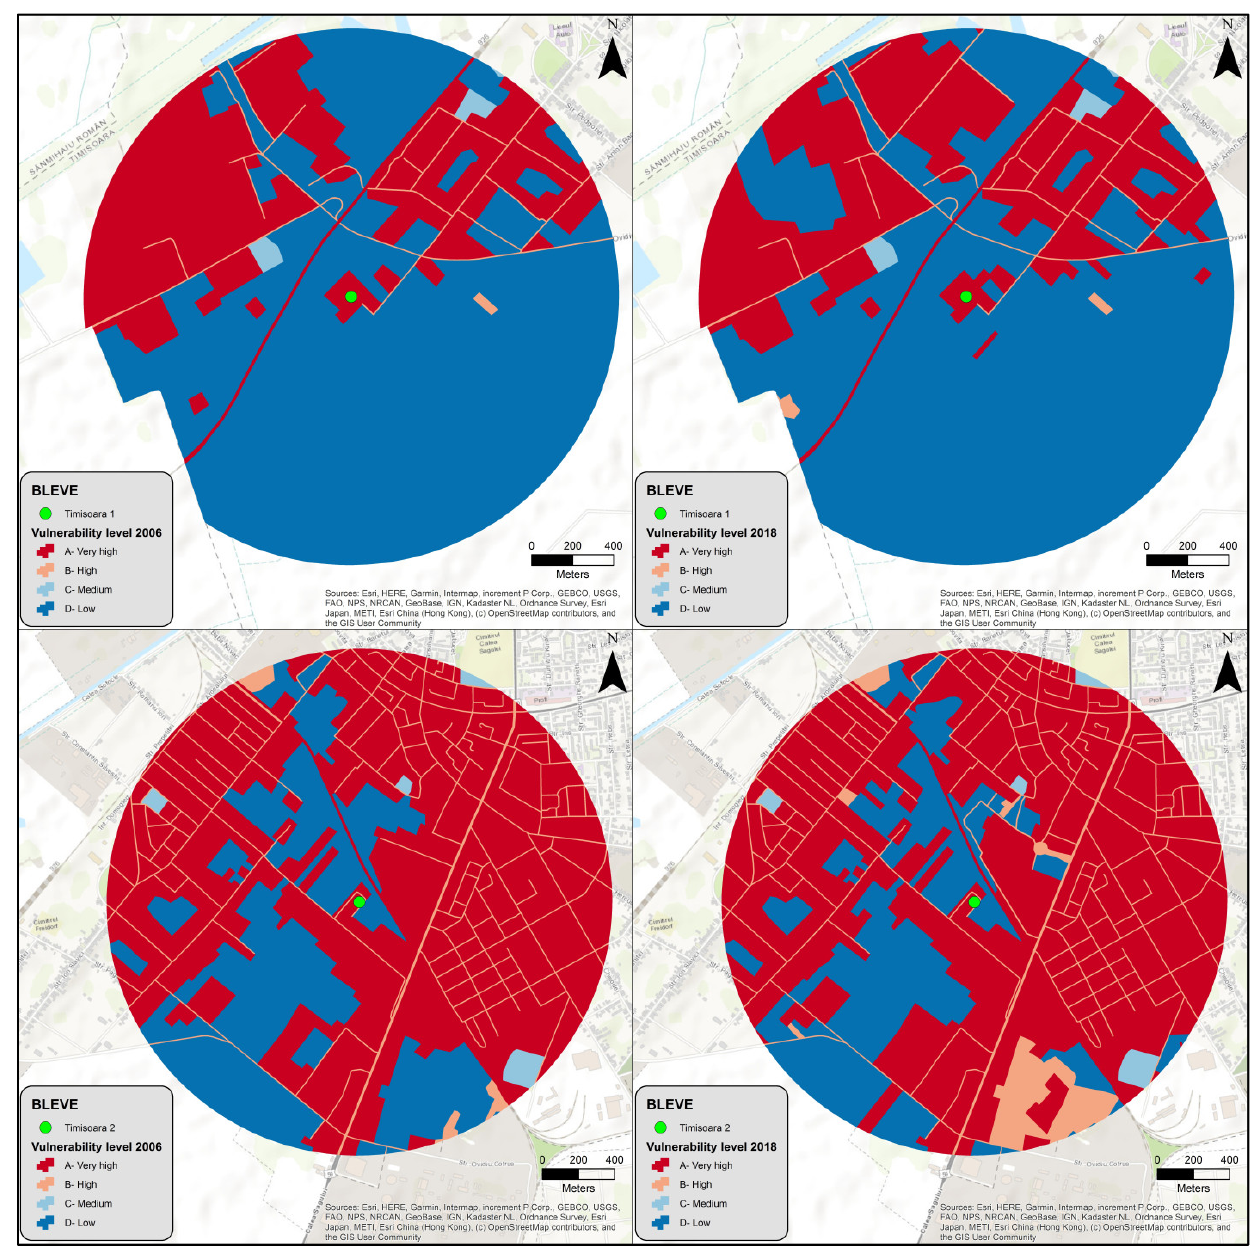
Figure 10. Vulnerability temporal variation within the reversible effects area for Timisoara 1 ( top ) and Timișoara 2 ( bottom )—worst-case scenario (BLEVE).